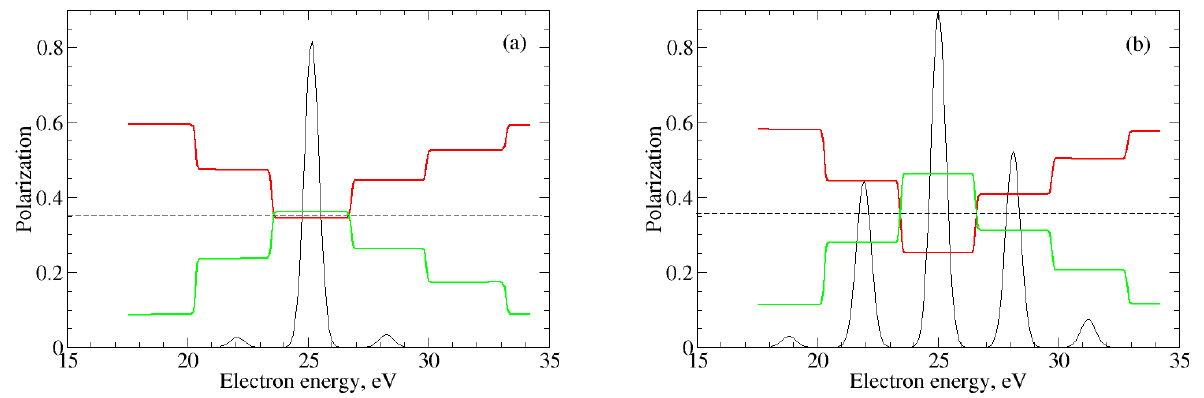
Figure 1. The photoelectron spin polarization component P 1/2 z for the XUV photon energy ¯ h ω X = 38.4 eV and the emission angle of 90 ◦ . Red line: left-circularly polarized dressing opti- cal pulse (OP), green line: right-circularly polarized OP. The thin solid line shows electron spectrum in arbitrary units. The OP intensity is panel ( a ) 0.5 10 12 W/cm 2 , panel ( b ) 5 10 12 W/cm 2 . The × × dashed straight line shows the spin polarization when the OP is absent.